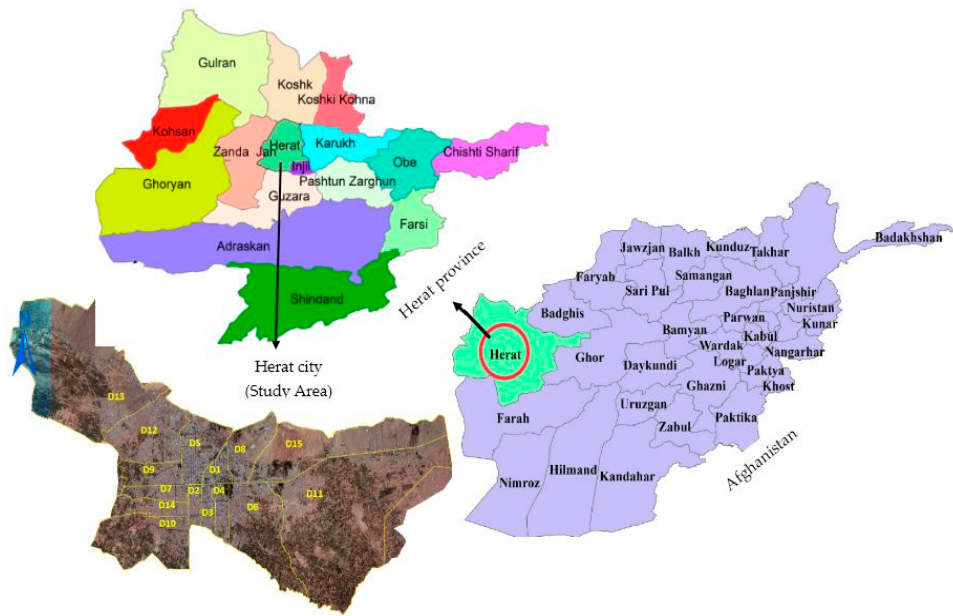
Figure 1. Map of Herat city (study area) and its urban districts. (D = district).